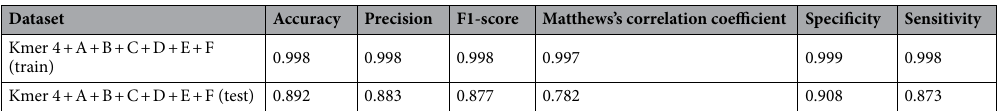
Table 4. The overall results of AptaNet before feature selection. Where Kmer 4 is 4mer frequency for aptamer properties. For protein properties: A indicates hydrophobicity, hydrophilicity, and mass; B indicates polarity, molecular weight, and melting point; C indicates transfer free energy, buriability, and bulkiness; D indicates solvation free energy, relative mutability, and residue volume; E indicates volume, amino acid distribution, and hydration number; F indicates isoelectric point, compressibility, and chromatographic index.